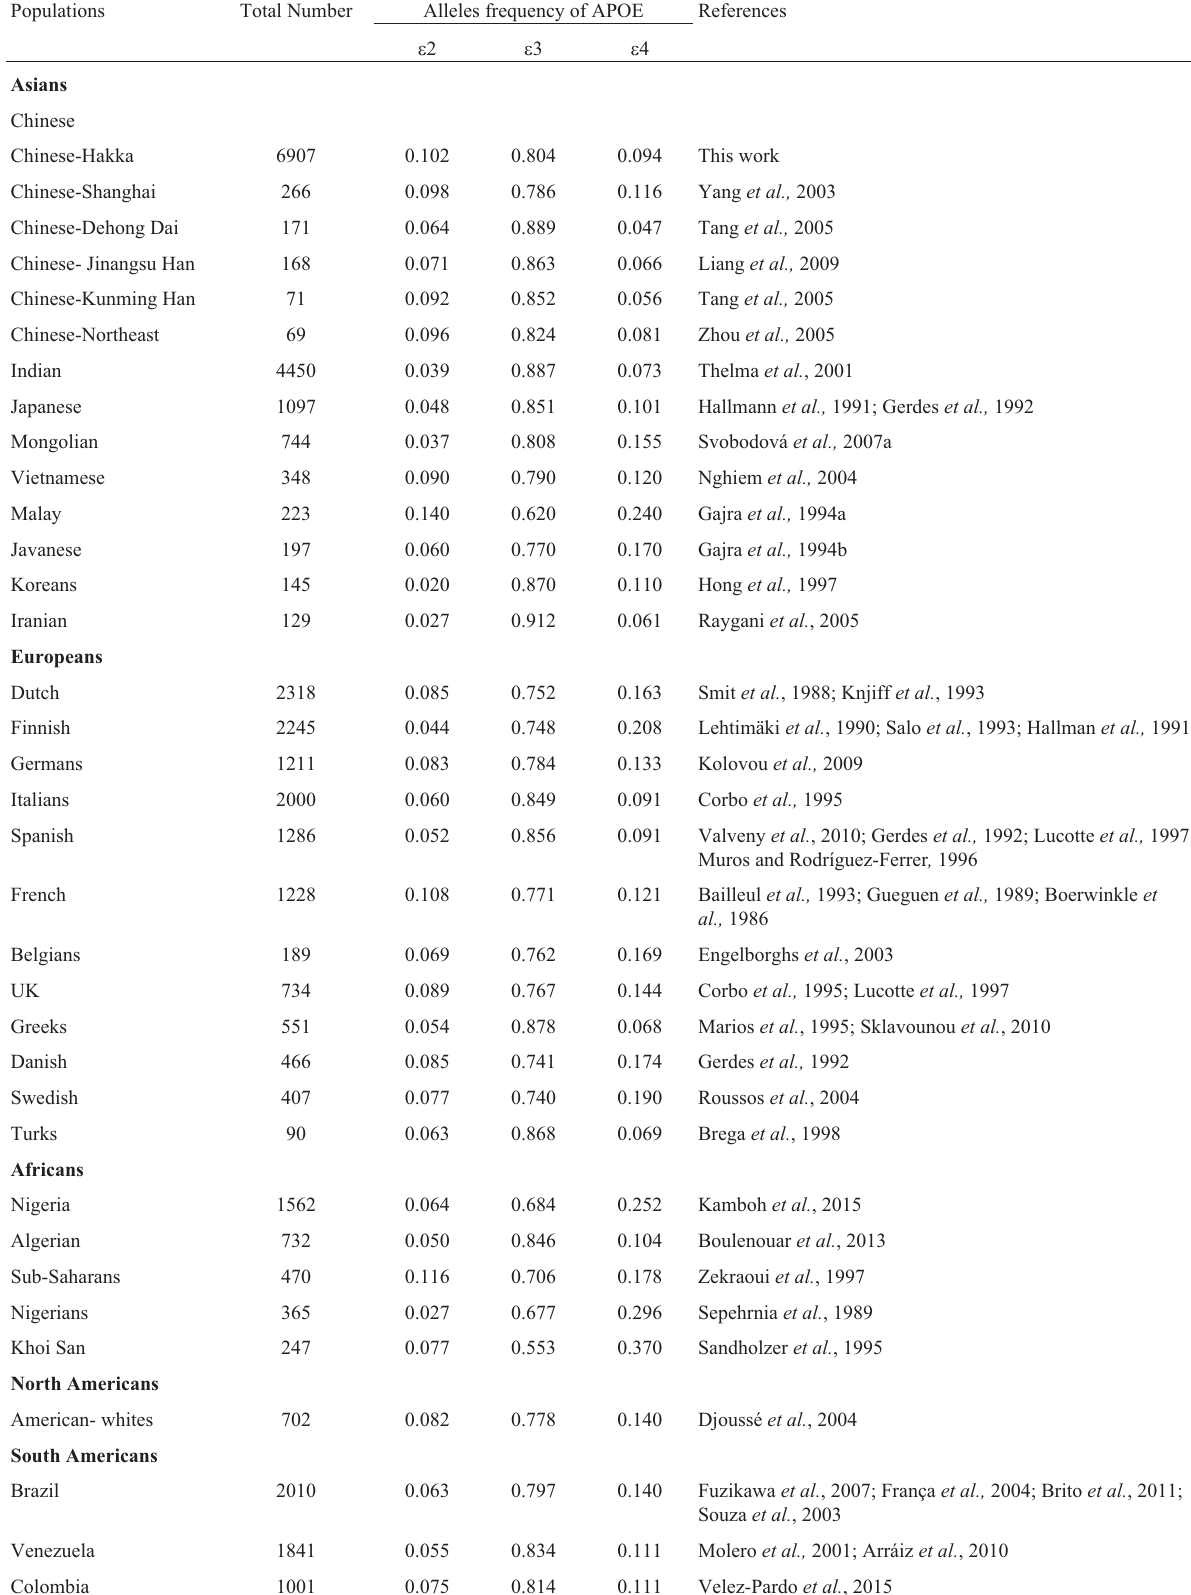
Table 2 - Distribution of APOE ( (cid:2) 2, (cid:2) 3, (cid:2) 4) allele frequencies among major study populations.